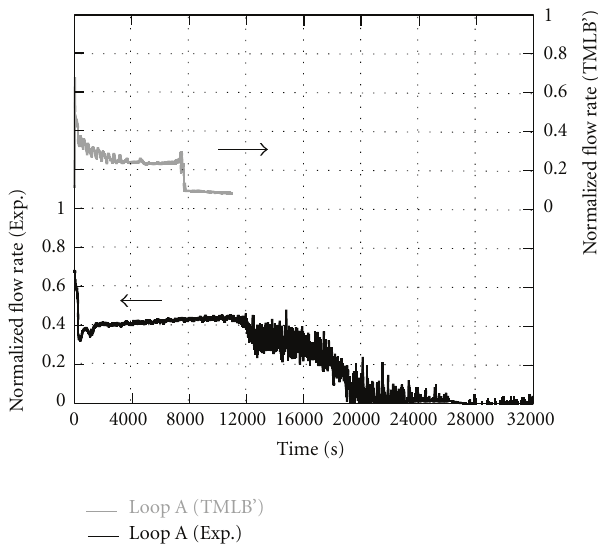
Figure 27: Comparison with TMLB’ scenario test results for SG secondary-side collapsed liquid level in loop with PZR.